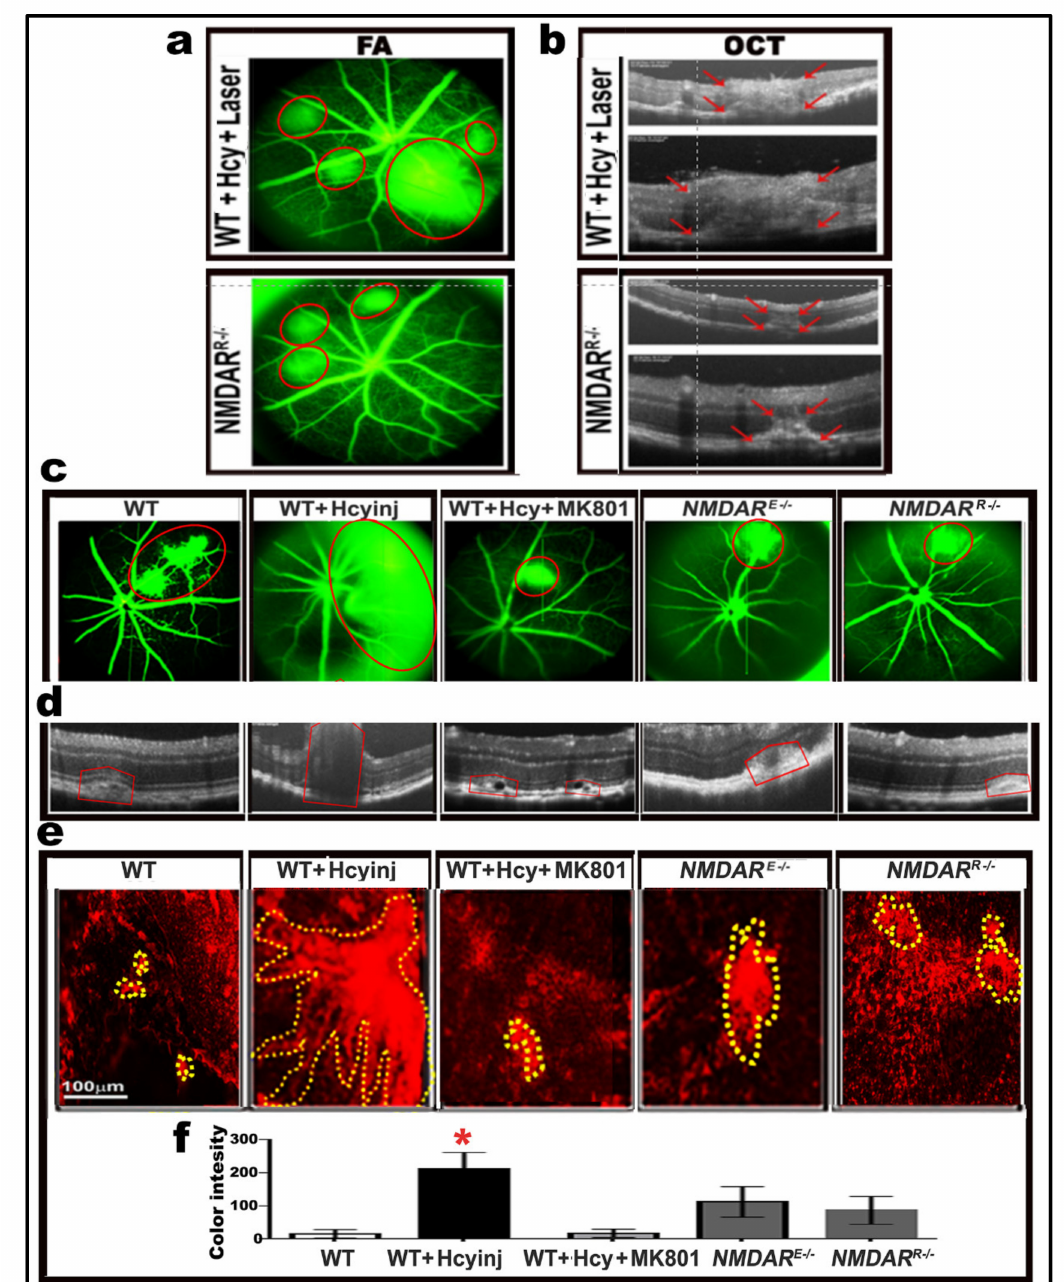
Figure 7. Knocking down the NMDAR protects retina after laser induction. ( a , b ) FA and OCT evaluation images of WT and NMDAR R − / − mice injected intravitreally with Hcy, showing marked retinal disruption and CNV induction (red circles in FA and red arrow on OCT), which extended through the whole retina after laser induction in the WT mice injected with Hcy, while knocking down the NMDAR in RPE cells was able to reduce the CNV and protect the retina from the Hcy effect in Hcy-injected NMDAR R − / − mice. ( c , d ) FA and OCT evaluation of retinal CNV after laser induction, showing that both the pharmacological (MK801) and the genetic inhibition of NMDAR (endothelial NMDAR E − / − and RPE, NMDAR R − / − ) were able to protect the retina from Hcy-induced CNV after exposure to laser burns (outlined by red in both FA and OCT). ( e , f ) RPE flat-mounts were prepared from the same mice groups for further assessments; mounts were stained for vascular marker isolectin-B4 (IB4) and imaged by All-in-One Fluorescence Microscope (BZ-X800), Keyence corporation. CNV areas are circled in yellow and CNV sizes were assessed by image J program quantitative images representing CNV sizes that confirmed the FA and OCT data. ( n = 6 mice per group). Calibration bar: 100 µ m. * p <